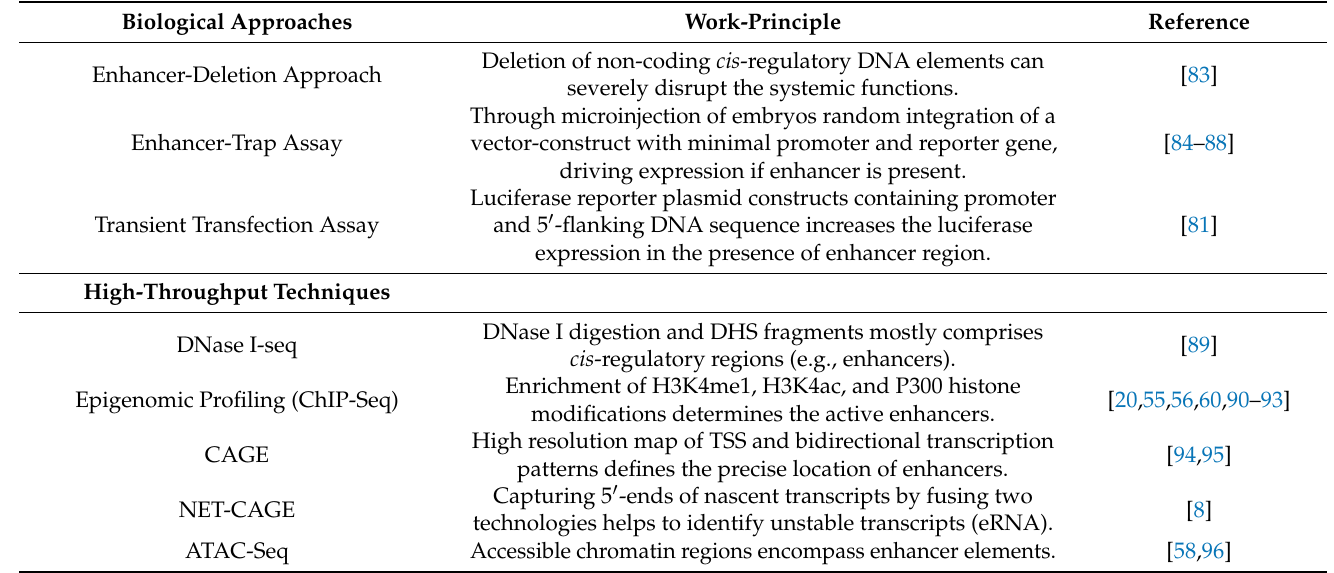
Table 1. A list of methods known for enhancer identification. Biological Approaches